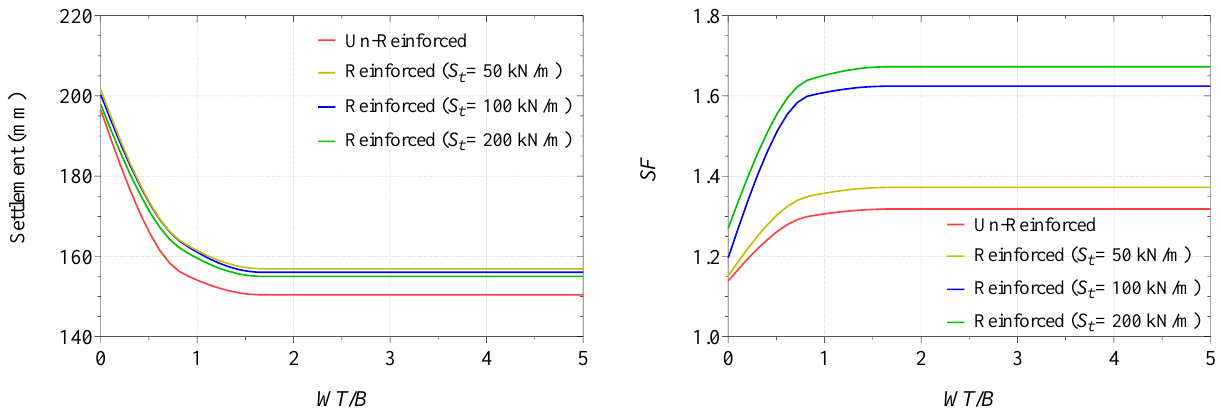
Figure 8. The settlement and the safety factors of the soil-footing system due to the changes of WT/B and St (for all tests: u=0.5 m, h=0.5 m, b=12 m, and n=3)